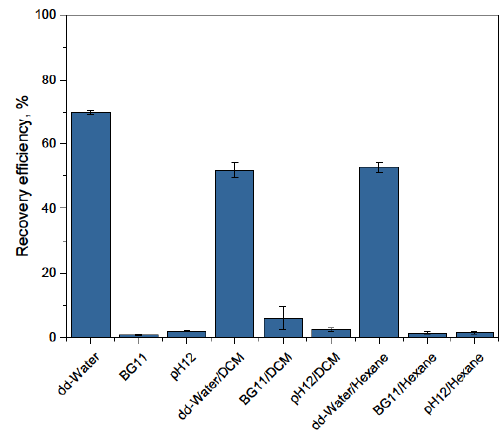
Figure 6. Recovery efficiency of S. ovalternus for mass ratio BION/microalgae of 1.5 g/g at pH 8.35 (or pH 12 when directly stated).